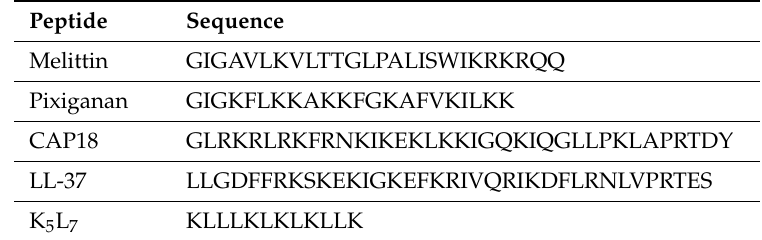
Table 1. Sequences of membrane-active peptides (MAPs)